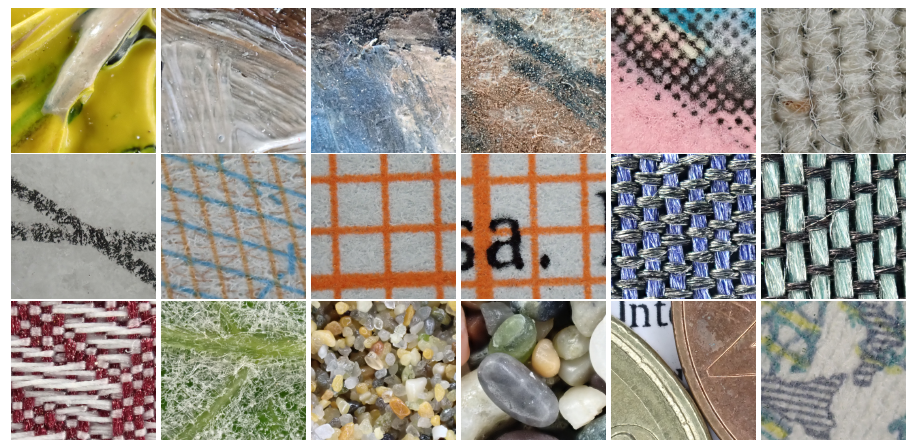
Figure 6. Samples.